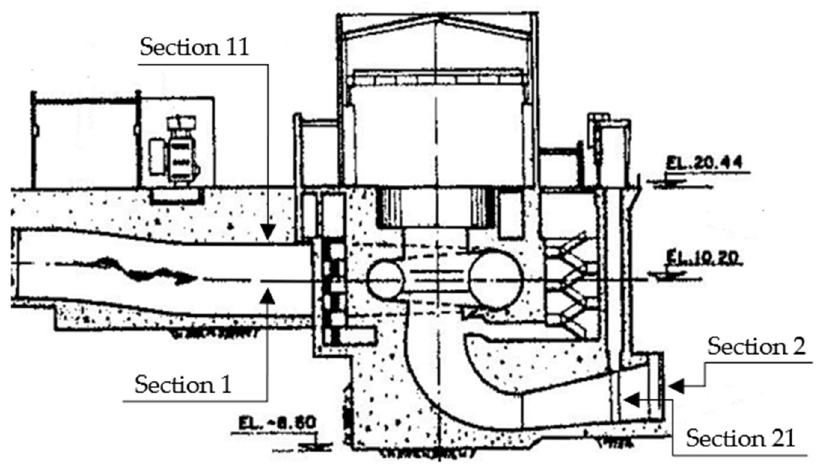
Figure 14. Longitudinal view, measurement points [24].